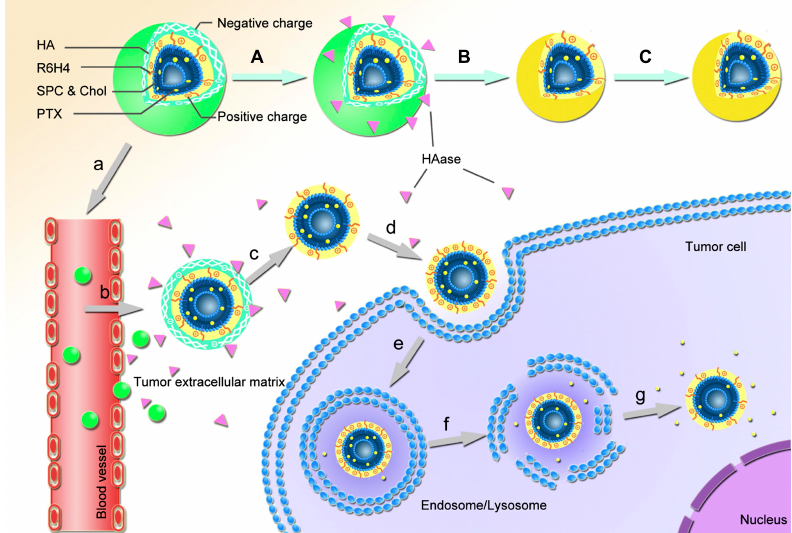
Figure 14. Schematic design of the dual-decorated liposomes (PTX/HA-R6H4-L) for tumor-targeted drug delivery. R6H4 is a cell penetrating peptide. PTX: paclitaxel, SPC: Soy phosphatidylcholine and Chol: Cholesterol A—Degradation of HA by HAase. B—Disassembly of PTX/HA-R6H4-L to PTX/R6H4-L. C—Tumor pH-induced PTX/R6H4-L for enhanced cell penetration. a—Intravenous injection of liposomes. b—Accumulation of liposomes at the tumor site through passive and active targeting. c—Degradation of HA by HAase together with the exposure of R6H4 at HAase-rich tumor milieu. d—pH-Response of R6H4 to mildly acidic tumor microenvironment for improved cellular uptake. e—Internalization of liposomes into the tumor cells. f—Endosomal/lysosomal escape. g— Cytoplasmic release. From [102].